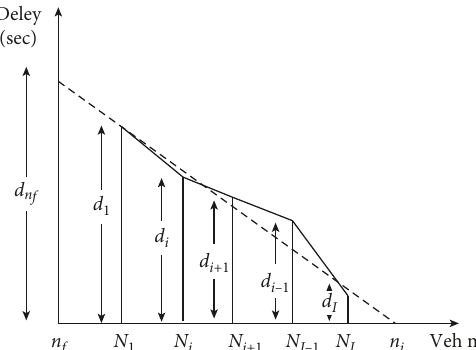
Figure 1: Delay polygon obtained using sample travel time data.